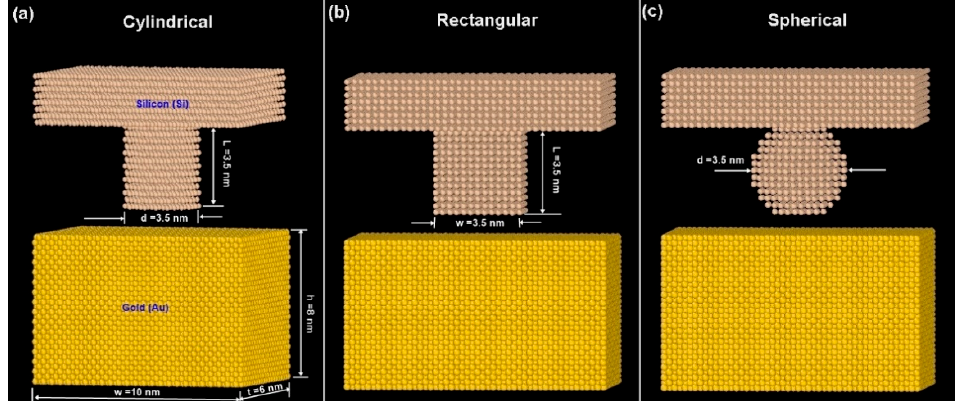
Figure 1. Different mold patterns with dimensions. ( a ) Cylindrical ( b ) Rectangular ( c ) Spherical. Molecular dynamic models (mold and substrate) employed periodic boundary conditions in the lateral plan ( x and y axis) to replicate the experimental nanoimprint lithography (NIL) setup. The elemental interactions between the mold and the substrate were modeled using the Modified Embedded Atom Method (MEAM) potential [48]. The MEAM is a comprehensive potential to capture all the mold-substrate interactions within the NIL process. The MEAM potential values mentioned in Table 1 for gold (Au) and silicon (Si) were recalled from the library of MEAM potential parameters and these values were applied for Si-Au interaction as well as Au-Au interaction. In the MEAM formulation, the total energy E of a system of atoms is defined by Equation (1).